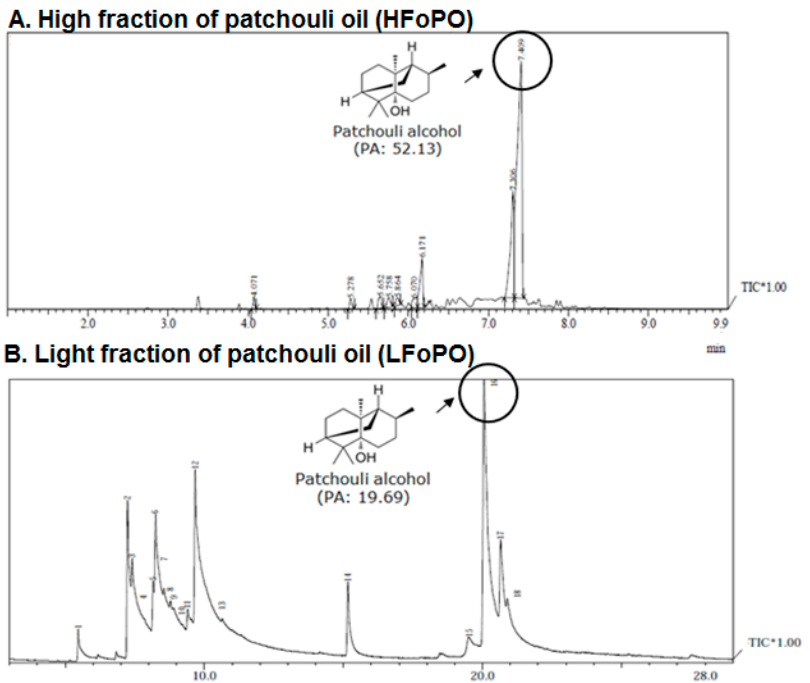
Figure 4. The GC-MS spectrum of patchouli oil; ( A ) High fraction of patchouli oil (HFoPO) and ( B ) Light fraction of patchouli oil (LFoPO).